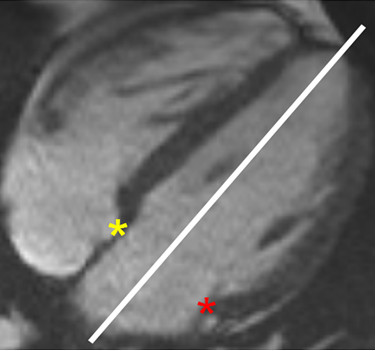
Septal and lateral AVJ. Yellow and red asterisks mark the septal and lateral AVJ, respectively, on this 4-chamber view. A reference line for longitudinal AVJ motion bisects the LV between the apex and the midpoint of the mitral annulus. AVJ = atrioventricular junction; LV = left ventricle.